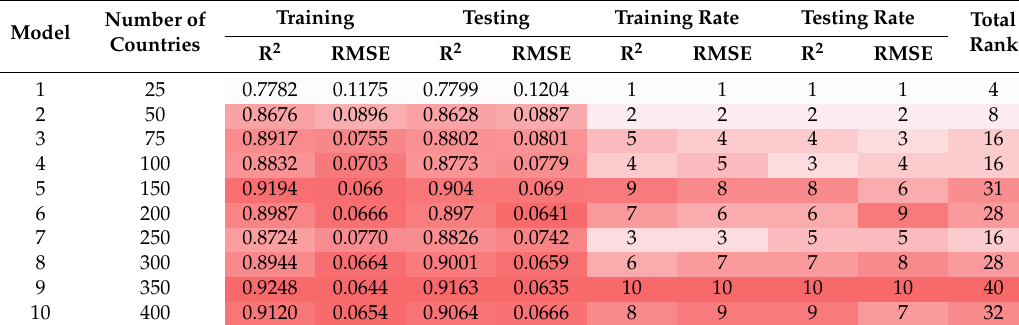
Table 2. Ranking and color intensity ranking (CIR) systems to select the best imperialist competitive algorithm-artificial neural network (ICA-ANN) model.